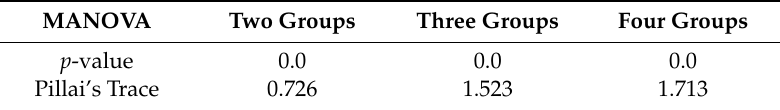
Table 2. Analysis results of multivariate analysis of variance